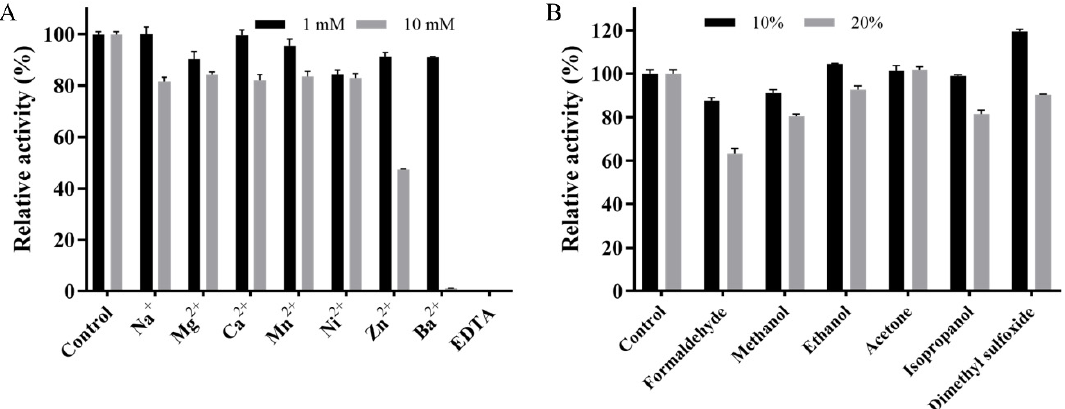
Figure 5. Effects of metal ions ( A ) and organic solvents ( B ) on the activity of